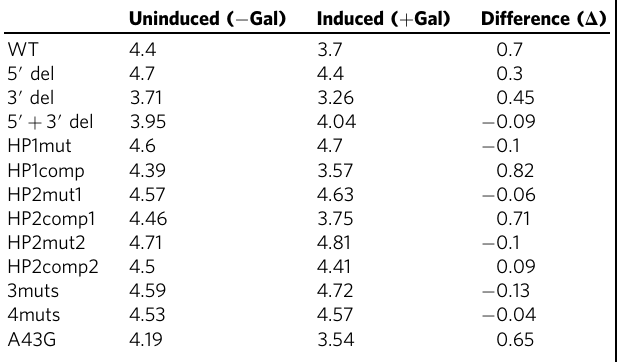
Table 1 GFP expression level (log) with and without induction in the presence of RPL1B UTR